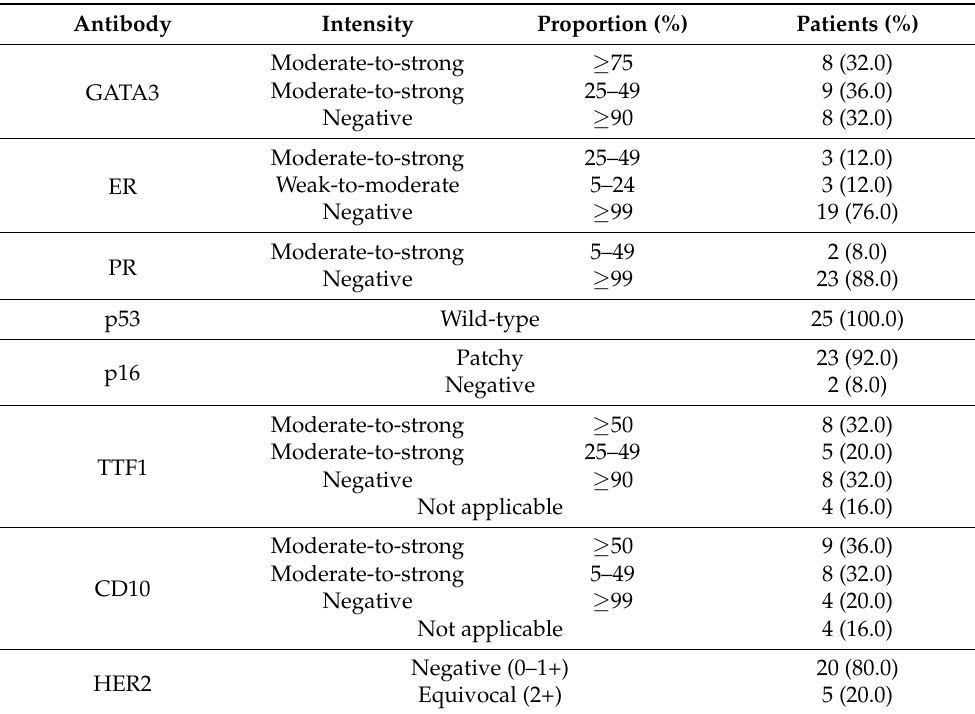
Table 4. Summary of IHC